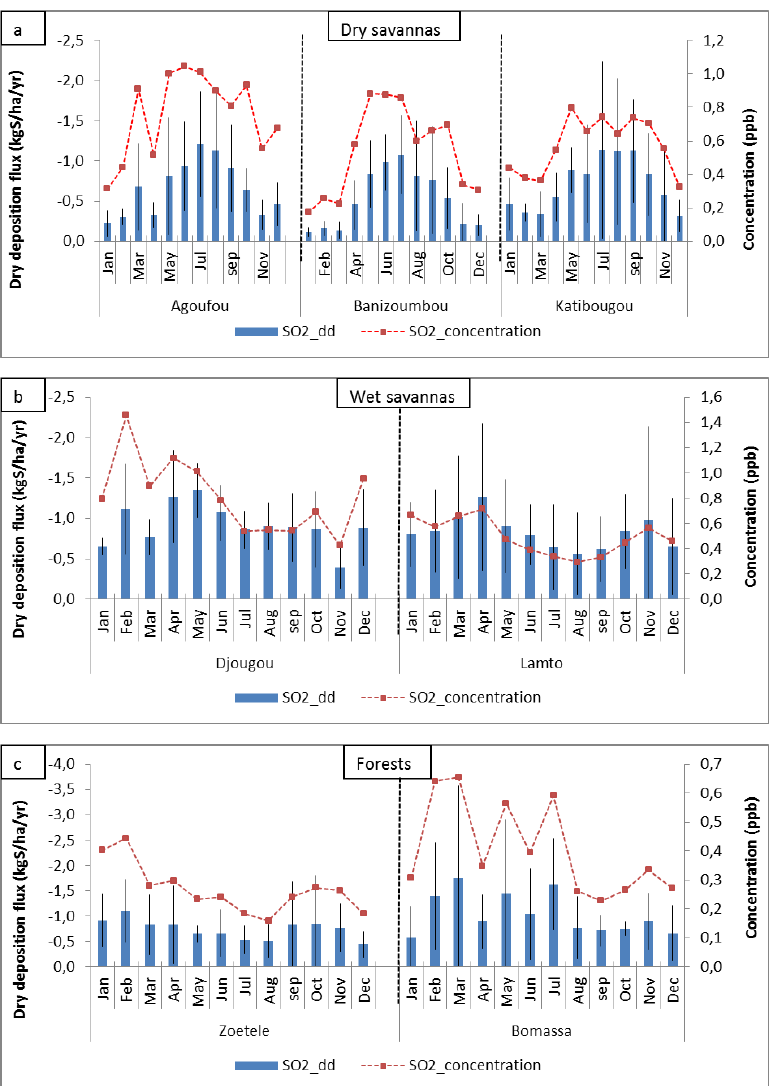
Fig. 8. Evolution of monthly dry deposition fluxes of SO 2 (SO 2 _dd) inkgSha − 1 yr − 1 (2002–2007) on the transect dry savannas (a) , wet savannas (b) and forests (c) associated with evolution of SO 2 concentrations